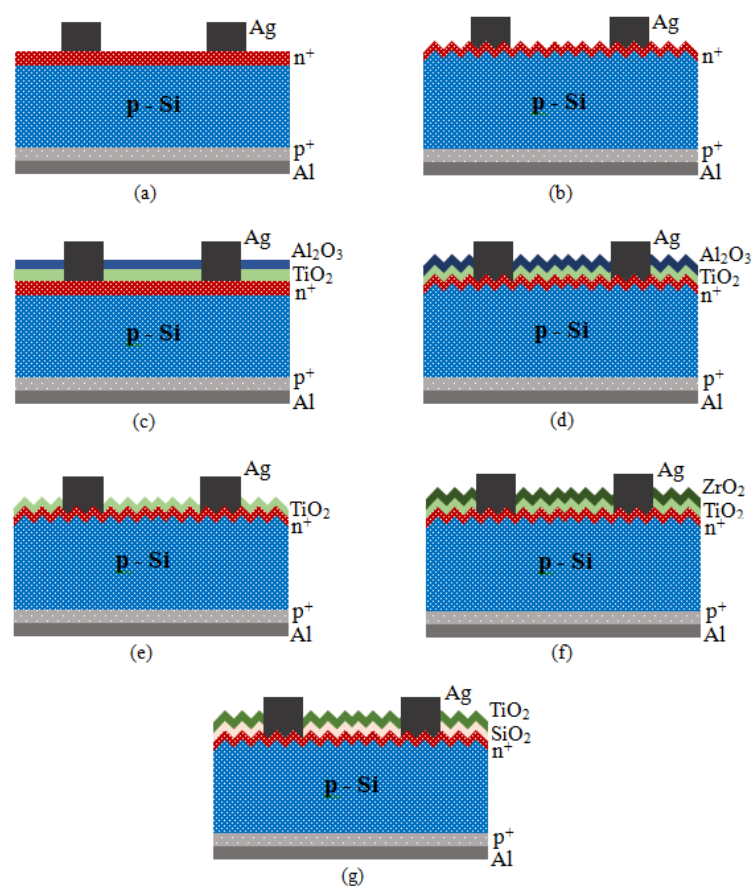
Figure 1. Schematics of solar cell structures fabricated with non ‐ vacuum process techniques with various surface structures and with various ARC films, ( a ) <AI/ p +/ p − Si/ n +/Ag> with flat surface, ( b ) <AI/ p +/ p − Si/ n +/Ag> with textured surface, ( c ) <AI/ p +/ p − Si/ n +/TiO 2 /AI 2 O 3 /Ag> with flat surface, ( d ) <AI/ p +/ p − Si/ n +/TiO 2 /AI 2 O 3 /Ag> with textured surface, ( e ) <AI/ p +/ p − Si/ n +/TiO 2 /Ag> with textured surface, ( f ) <AI/ p +/ p − Si/ n +/TiO 2 /ZrO 2 /Ag> with textured surface, ( g ) <AI/ p +/ p − Si/ n +/SiO 2 /TiO 2 /Ag> with textured